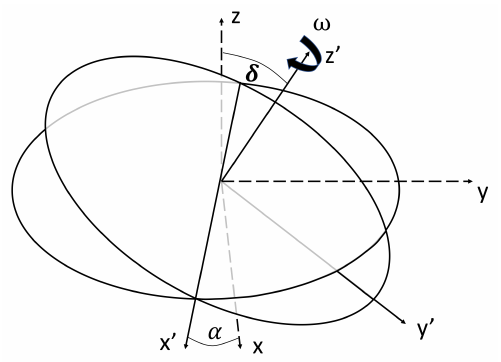
Figure 1. Euler angles describing spin axis orientation with respect to the ICRF. The axes of the ICRF are denoted by ( x , y , z ), while the axes of the body-fixed frame are given by ( x (cid:48) , y (cid:48) , z (cid:48)